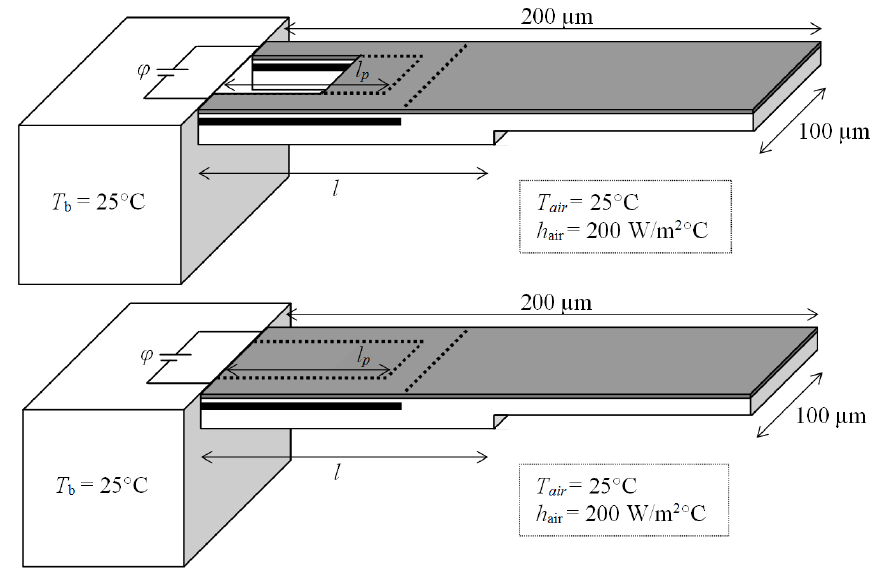
Figure 1. Schematic of slotted ( top ) and monolithic ( below ) step microcantilever designs with u-shaped